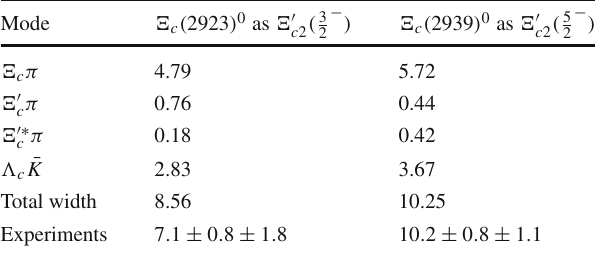
Table 7 Strong decays of the (cid:2) c ( 2923 ) 0 and (cid:2) c ( 2939 ) 0 under j = 2 assignments in